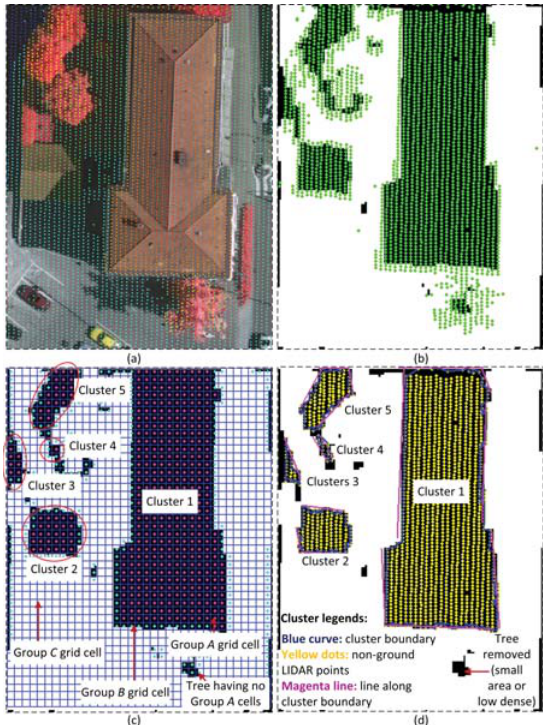
Figure 2: A sample scene from the Vaihingen data set: (a) raw LIDAR points overlaid on an orthoimage, (b) building mask and non-ground LIDAR points, (c) grouping and clustering of the mask grid cells, and (d) clusters of non-ground LIDAR points on buildings and large trees.